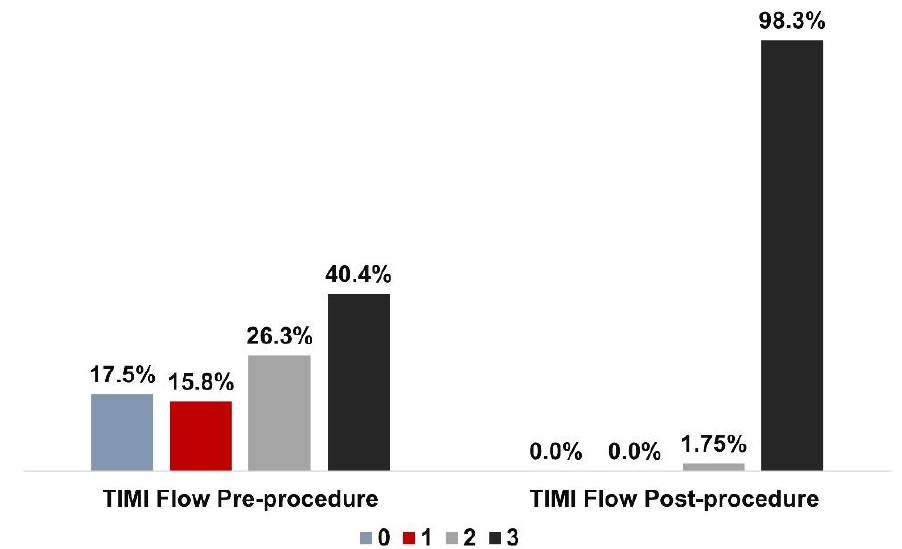
Figure 3. Thrombolysis in myocardial infarction (TIMI) flow pre- and post-procedure.